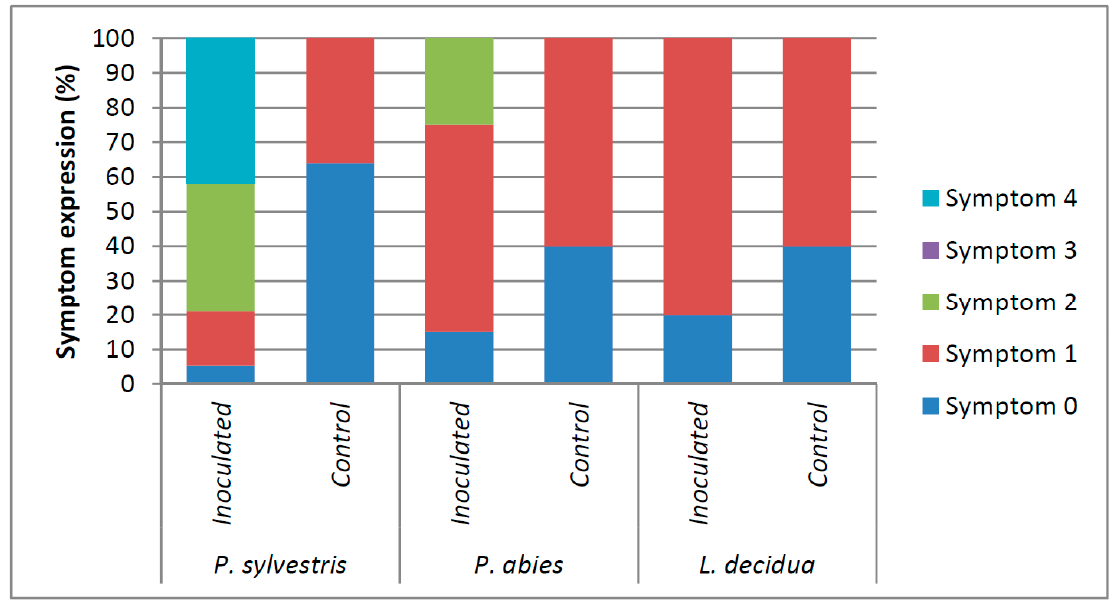
Figure 2. Type of symptomatology showed by Pinus sylvestris , Picea abies , and Larix decidua seedlings at the end of the experiment following the Correll et al. [53] scale, where 0 = healthy plant, 1 = resin and/or necrosis at the point of inoculation and healthy foliage, 2 = resin and/or necrosis beyond the point of inoculation, 3 = accentuated wilting and appreciable dieback, 4 = dead plant.